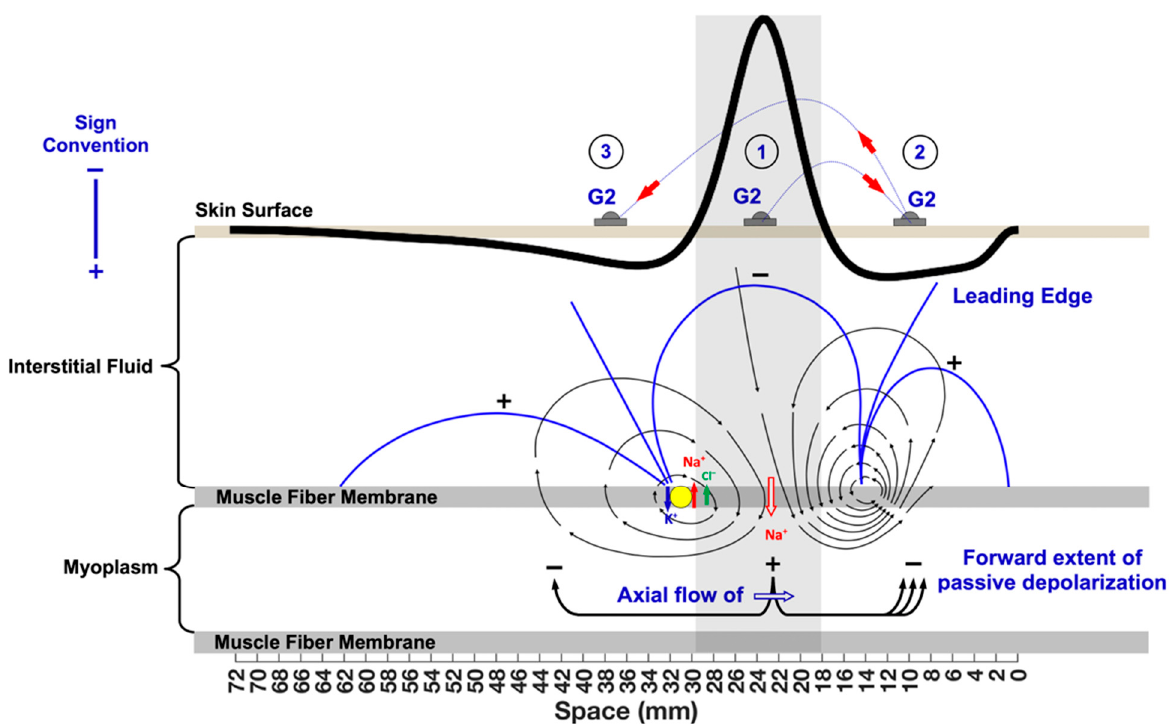
Figure 3. The propagating components of the muscle fiber action potential (MFAP). The MFAP is depicted with its corresponding current lines (black lines going from the + pole to the − pole) and equipotential lines (blue lines surrounding each pole) originating from the dipole. The locations of G2 on the skin surface are: 1—over the depolarization zone; 2—the leading edge; and 3—the repolarization zone. The muscle fiber–tendon end-effect is circled and is represented by equipotential lines compressing at the muscle–tendon junction immediately above. This is an approximation since the actual action potential is better modeled as a double dipole (a tripole).